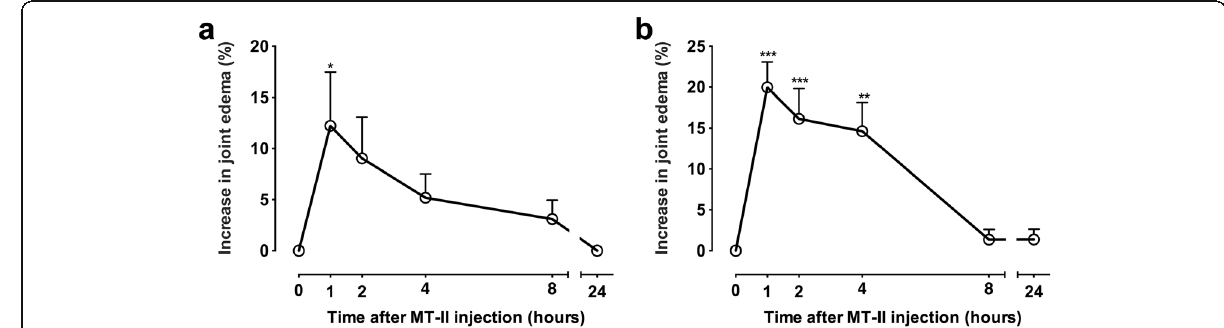
Fig. 2 Edema induced by MT-II in ( a ) tibio-tarsal and ( b ) femoral-tibial-patellar rat joints. MT-II (10 μ g/articulation) was injected in 25 (tibio-tarsal articulation) or 50 μ L (femoral - tibial-patellar articulation) of PBS (vehicle). The same volume of PBS was injected in the contralateral